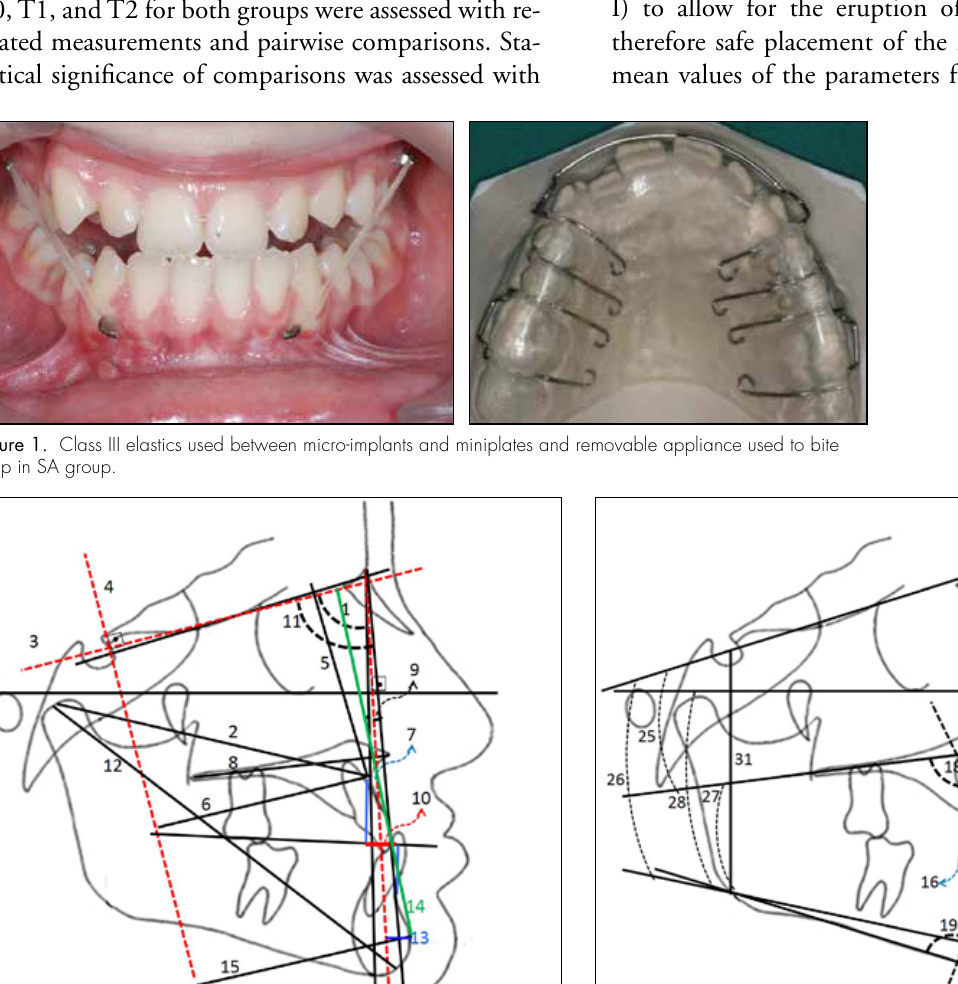
Figure 2. Linear and angular cephalometric variables used for this study. The horizontal reference line (HRL) was between the tuberculum sella and wing point of the sphenoid bone, and the vertical reference line (VRL) was a perpendicular line passing through the T point of the sphenoid bone. The horizontal and vertical perpendicular distances from the points A and Pg were calculated. a. Maxillary and Mandibular skeletal and maxillo-mandibular measurements, b. Dentoalveolar, soft tissue angular and facial height